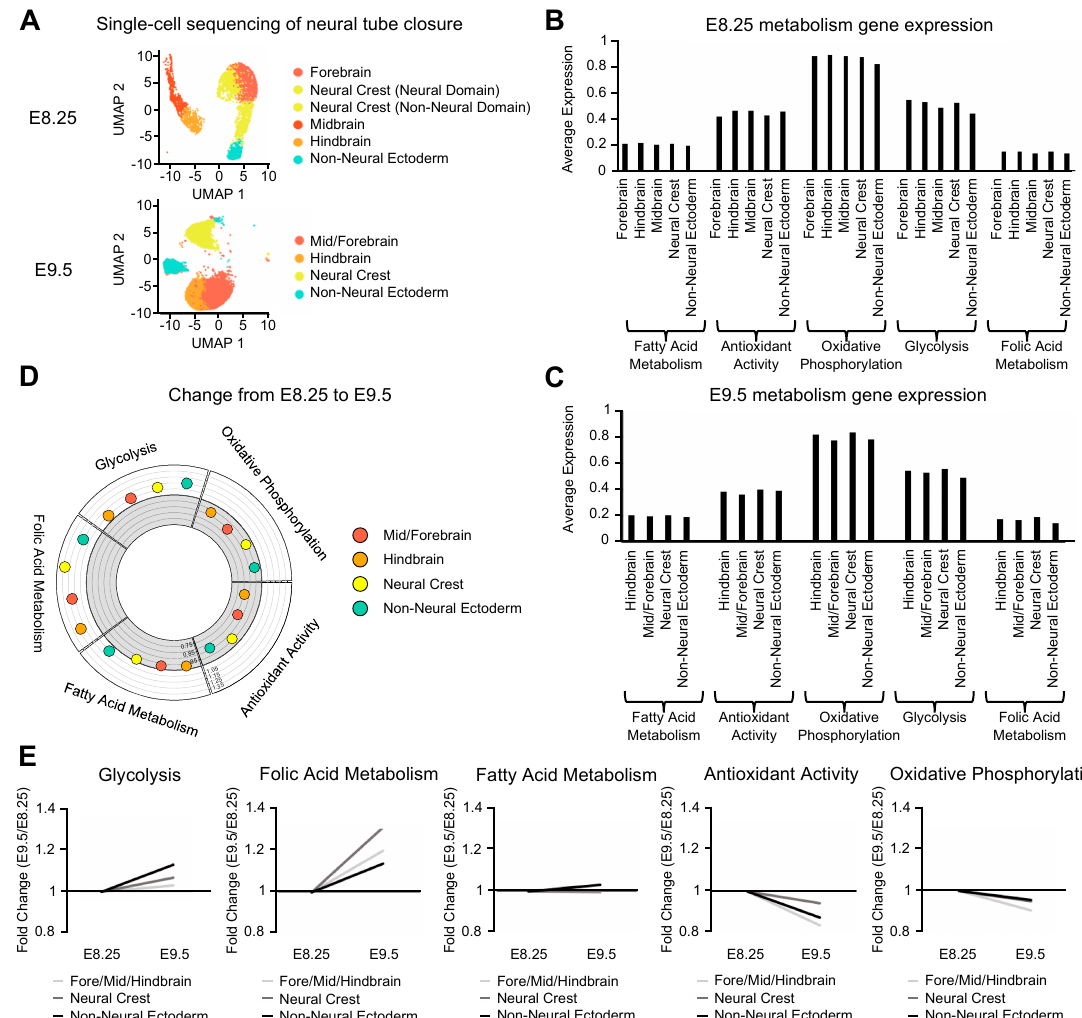
Figure 2. Single-cell sequencing reveals metabolic contributions to neural tube closure. ( A ) Uniform Manifold Approximation and Projection for Dimension Reduction (UMAP) plot showing the ectoderm-derived cell populations that contribute to neural tube closure obtained from single-cell sequencing of the cranial region at E8.25 and E9.5. ( B ) Bar plot showing gene expression of metabolic pathways in ectoderm-derived cell at E8.25 and ( C ) E9.5. ( D ) Circle plot showing the change in expression of metabolic pathways from E8.25 to E9.5 for each ectoderm-derived cell population. The white exterior region of the plot represents upregulation while the grey interior represents downregulation. ( E ) Line graphs showing change in expression for each metabolic pathway during neural tube closure in the neural tube, neural crest, and non-neural ectoderm. The same unbiased differential expression analysis was applied to E9.5 embryos, comparing ectoderm-derived versus non-ectoderm-derived cells after completion of neural tube closure (Figure 1D). Similar to our findings at E8.25, metabolic genes such as the glucose transporter Slc2a3 and stem cell factor Sox2 were among the differentially expressed genes at E9.5 (Figure 1E). In contrast to E8.25, we found an upregulation of genes at E9.5 that promote differentiation of the neuroepithelium (Figure 1E,F), such as Fgf15 [43]. We identified a slight downregulation of antioxidant Selenop and the glutathione peroxidase, Gpx1, suggesting a decrease in antioxidant activity during neural tube closure (Figure 1E). Consistent with a decline in antioxidant activity, Mt1 , an antioxidant gene activated by the redox transcription factor Nrf1 [58], was downregulated in the ectoderm at E9.5 (Figure 1E). GO analysis of differentially expressed genes at E9.5 revealed similar predicted functions at E8.25, including categories such as glucose transmembrane transport and the cell–cell adhesion